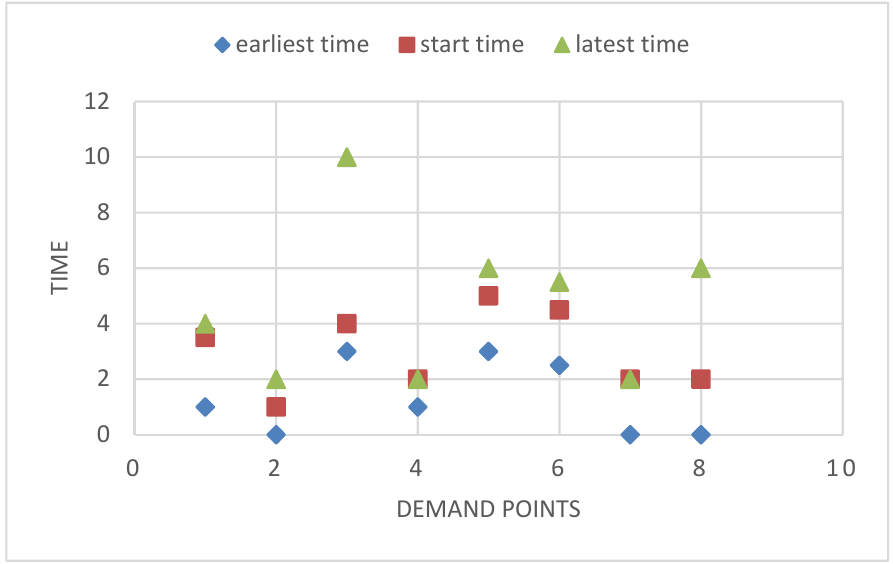
Figure 5. Compliance check for soft time windows.